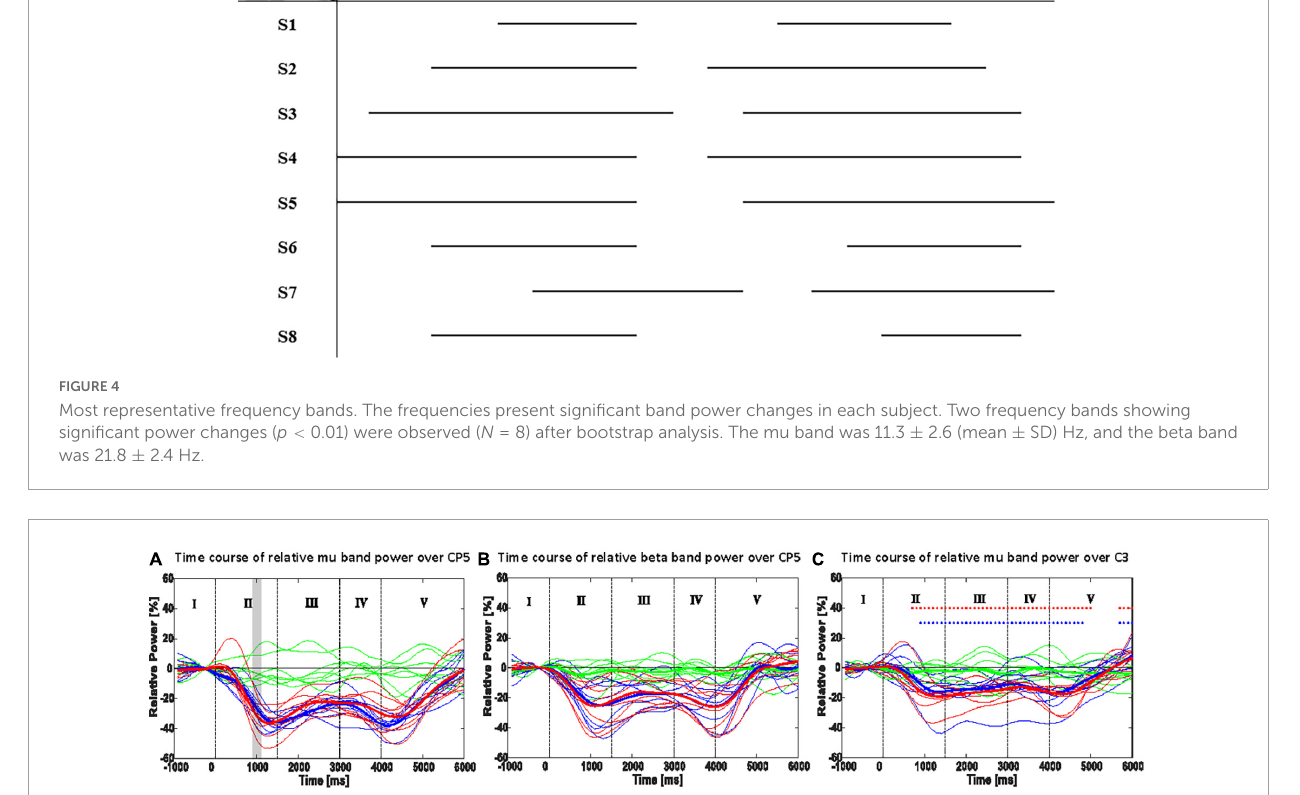
FIGURE5 Time course of the most responsive electrode in power (ERD/ERS): CP5 or P5 of mu rhythm (A) and beta rhythm (B) ; C3 in mu (8–13 Hz) power (C) . Thin lines show the mean band power of a single participant, and thick lines indicate the mean of the thin lines. Shaded areas in panels (A,B) show the 100 ms time bins, which resulted in a significant difference between the ORTHOFES and ORTHOSIS conditions using a two-sided Monte Carlo permutation test ( α = 0.05). Red asterisks (*) in panel (C) indicate the 100 ms time bin, which has a significant difference between REST and ORTHOFES of grand averages (thick lines) with a two-sided Monte-Carlo permutation test ( α = 0.05). Blue asterisk (*) indicates the same between REST and Orthosis. Green, red, and blue lines represent REST, ORTHOFES, and ORTHOSIS, respectively. I: pre-movement phase, II: opening phase, III: stretched phase, IV: returning phase, and V: post-movement